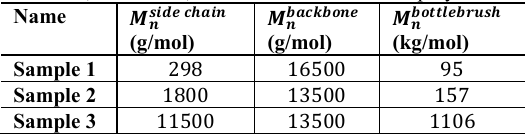
Table 1. Number average molecular weight, 𝑀 (cid:3041) , of side chains, backbones, and the entire bottlebrush polymer.